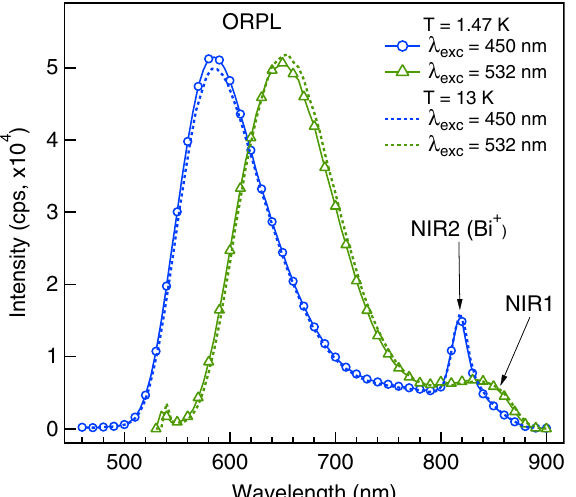
Figure 1. Photoluminescence spectra of SiO 2 :Bi at different excitation wavelengths and temperatures in the magnetic field 6